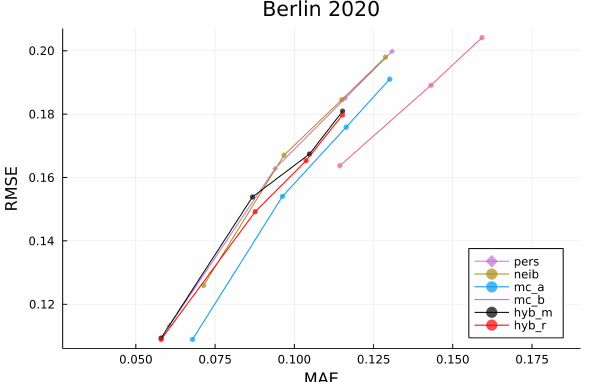
Figure 10. Mean absolute error (MAE) versus root mean square error (RMSE) for Berlin. For one step ahead (+1), the results for both mc a and mc b are the same, but only Variant a is visualized to avoid redundancy and/or overlapping. The same applies to the following figures. The results for the other three cities can be found in Figure A3 in Appendix A.